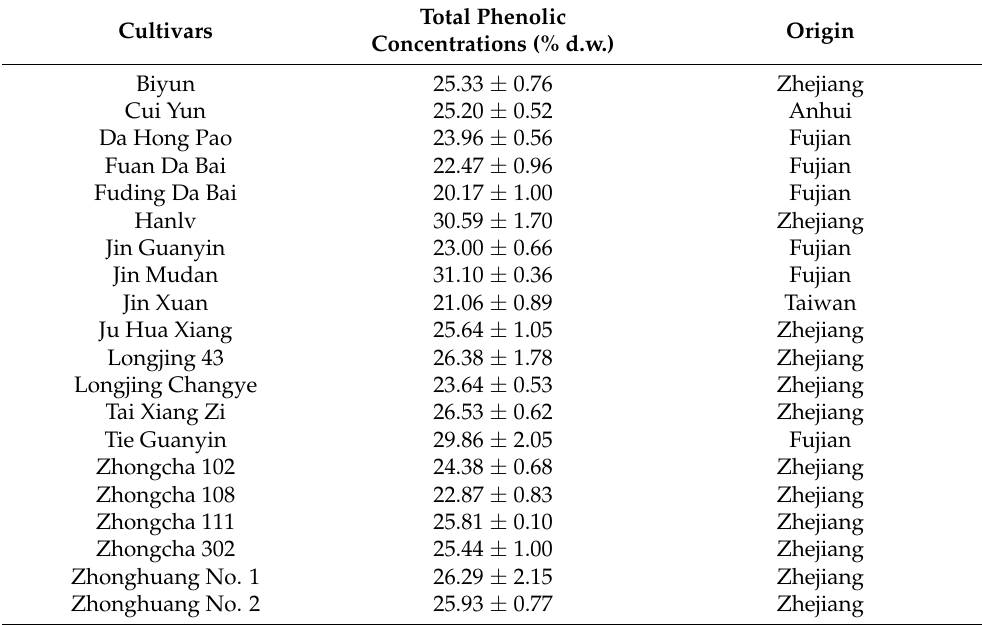
Table 1. Summary of the total phenolic concentrations and the origin of the selected tea cultivars. % d.w. = % foliar dry